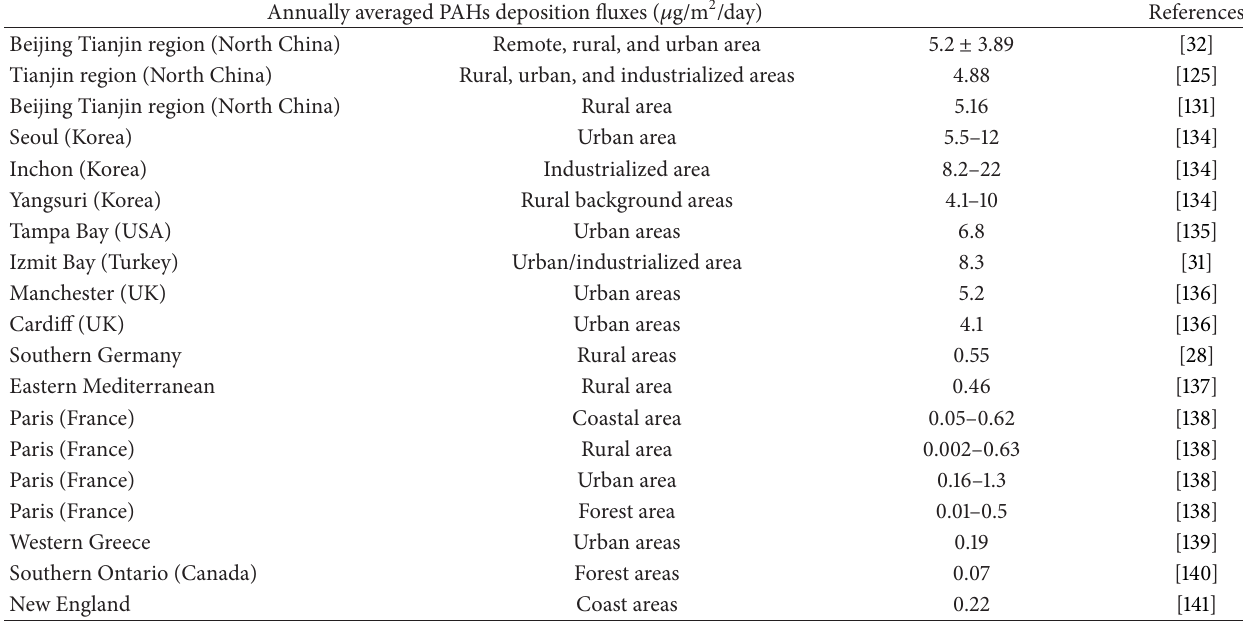
Table 8: Annually averaged PAHs deposition fluxes in different monitored